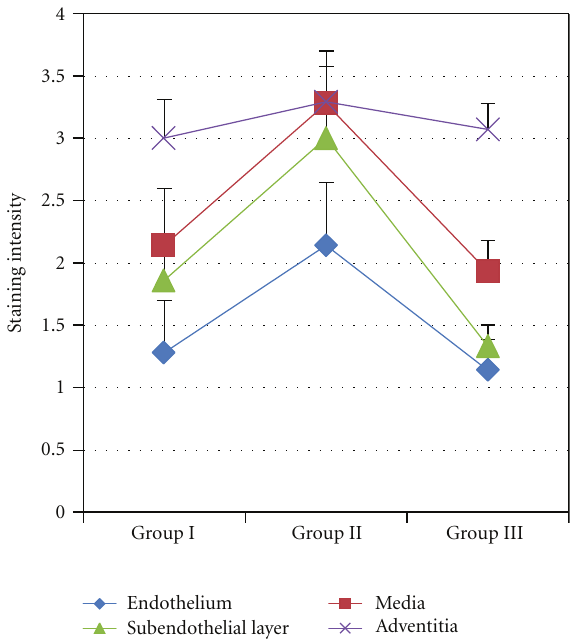
Figure 3: Changes of Bax expression in the walls of varicose veins. Statistically significant di ff erences in the endothelium; Group II versus Group III P < 0 . 01, in the subendothelial layer; Group I versus Group II P < 0 . 05 and Group II versus Group III P < 0 . 05, in the media-Group I versus Group II P < 0 . 01 and Group II versus Group III P < 0 .